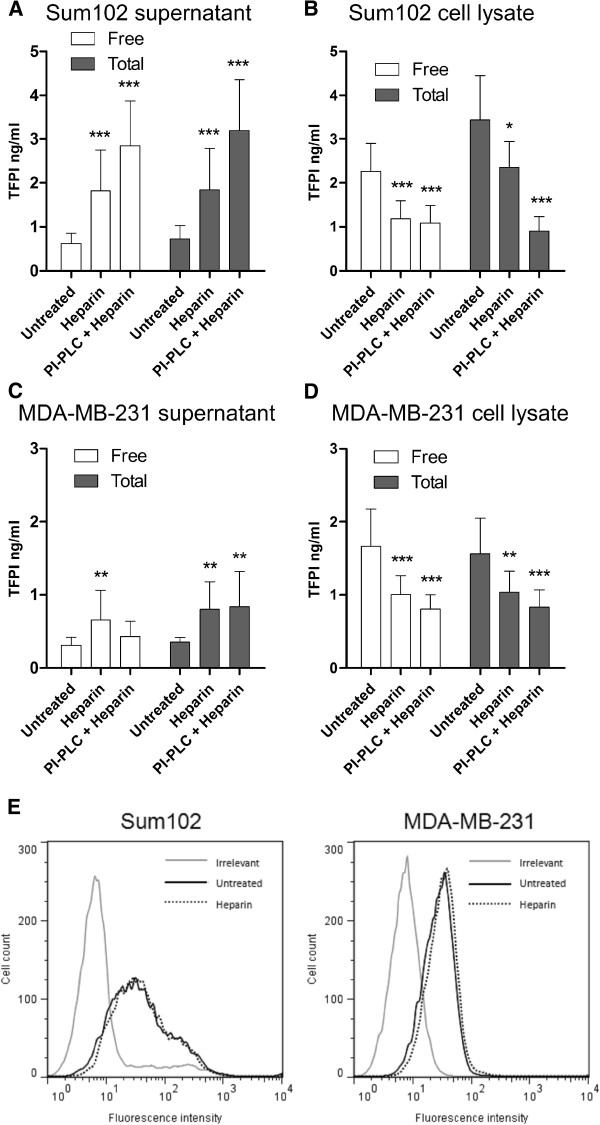
Heparin treatment of Sum102 and MDA-MB-231 cells. Serum-starved cells were treated with SFM (untreated) or heparin (5 U/mL) for 2 hours or with PI-PLC + heparin (2+2 hours) before the supernatant was removed and cells lysed or collected for flow cytometry analysis. The supernatant was discarded after PI-PLC pre-treatment. Free and total TFPI antigen measured in the supernatant (A and C) and lysate (B and D) of untreated, heparin or PI-PLC + heparin treated Sum102 (A and B) and MDA-MB-231 (C and D) cells. Mean values + SD (n ≥ 9) of three to six independent experiments are presented. Statistical comparisons were conducted between heparin/PI-PLC+heparin treated samples and untreated controls. (E) Flow cytometry analysis of untreated (black, solid) and heparin treated (black, dotted) Sum102 (left panel) and MDA-MB-231 (right panel) cells. One representative experiment of three is shown.